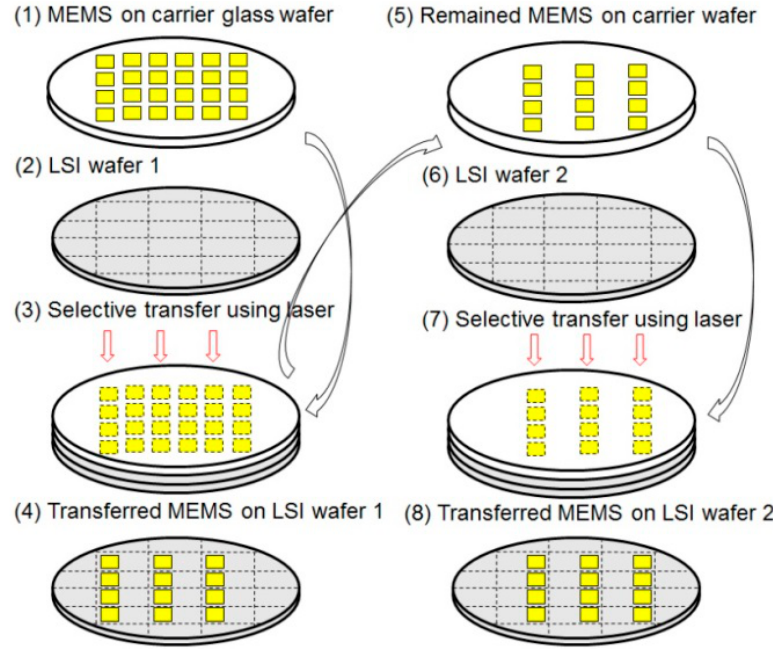
Figure 7. Concept of selective transfer.